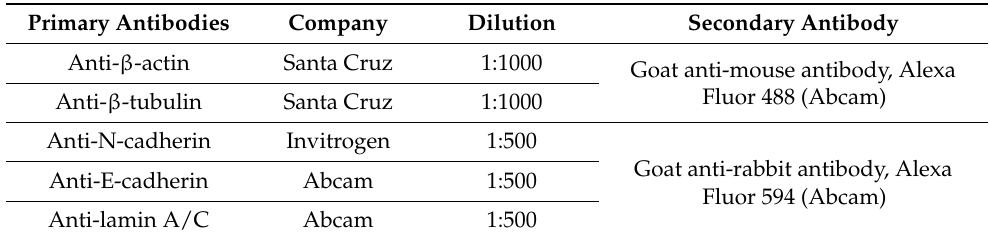
Table 1. Antibodies used in the immunofluorescence experiment. Antibodies were purchased from Abcam (Cambridge, England) Santa Cruz Biotechnology, (Dallas, TX) or Invitrogen. Primary Antibodies Company Dilution Anti- β -actin